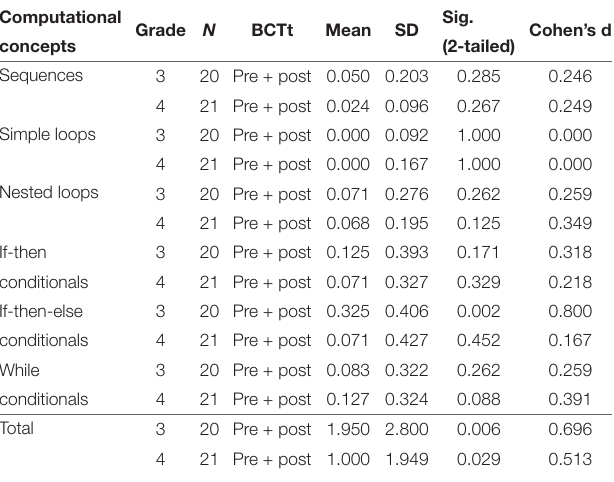
TABLE 4 | Post-hoc paired sample t -test (Grade 3 and